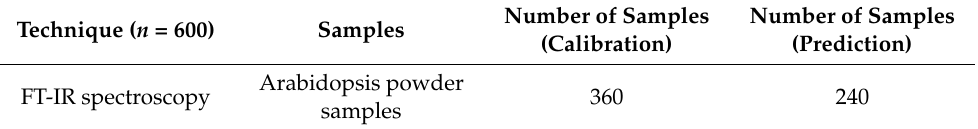
Table 4. Datasets used for FT-IR and FT-NIR spectroscopy.